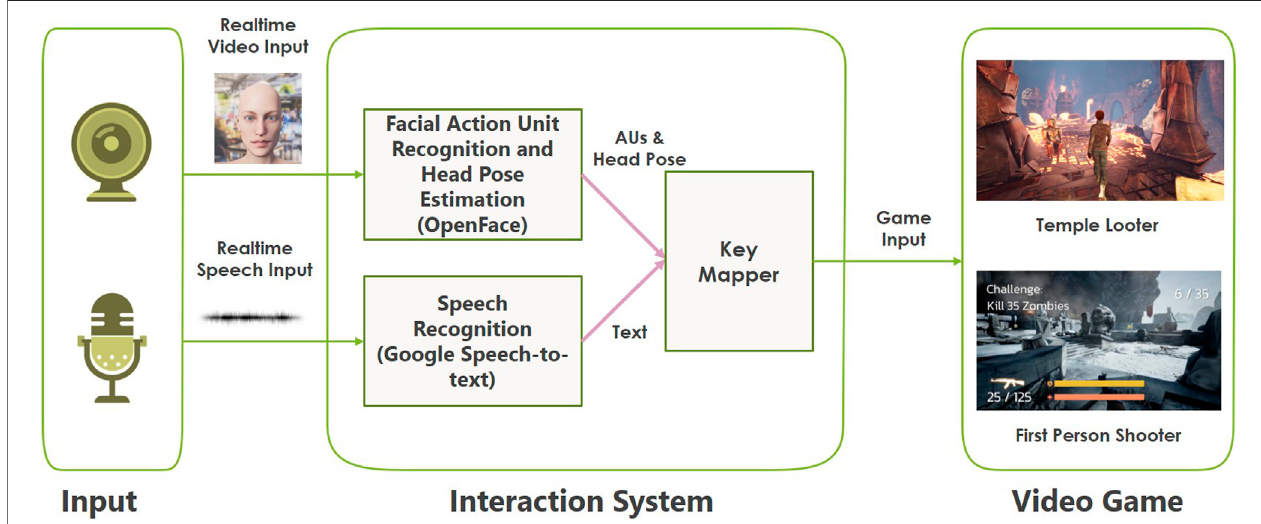
FIGURE 1 | The system pipeline shows video and speech data input that is processed and converted to keyboard bindings for controlling actions in each game [face image for Realtime Video Input from (Cuculo et al., 2019)].